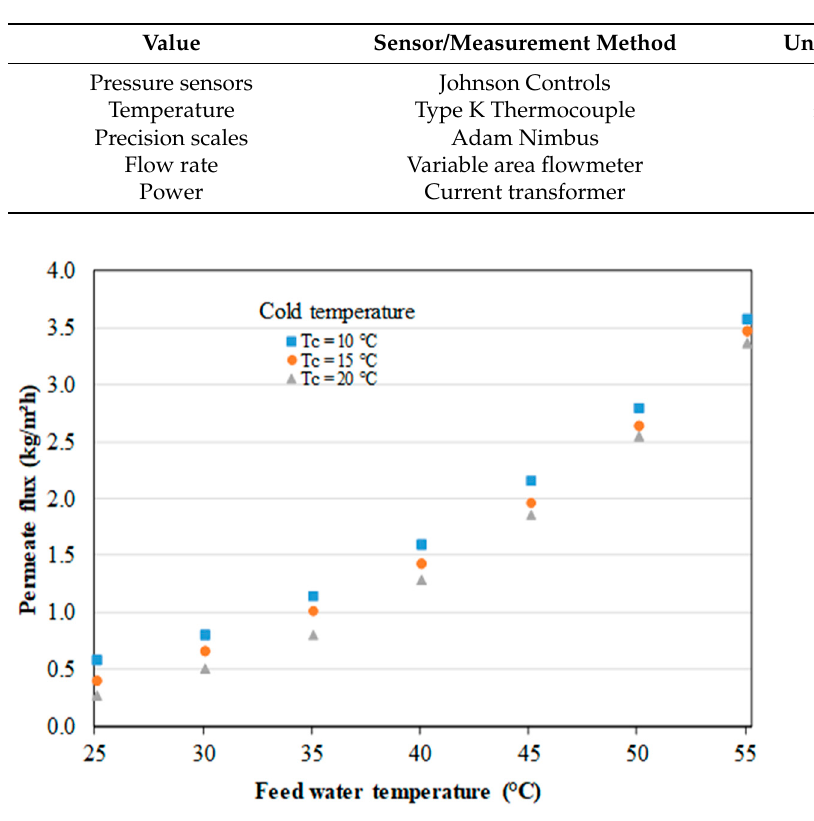
Figure 5. Effect of hot and cold feed water temperatures on permeate flux.